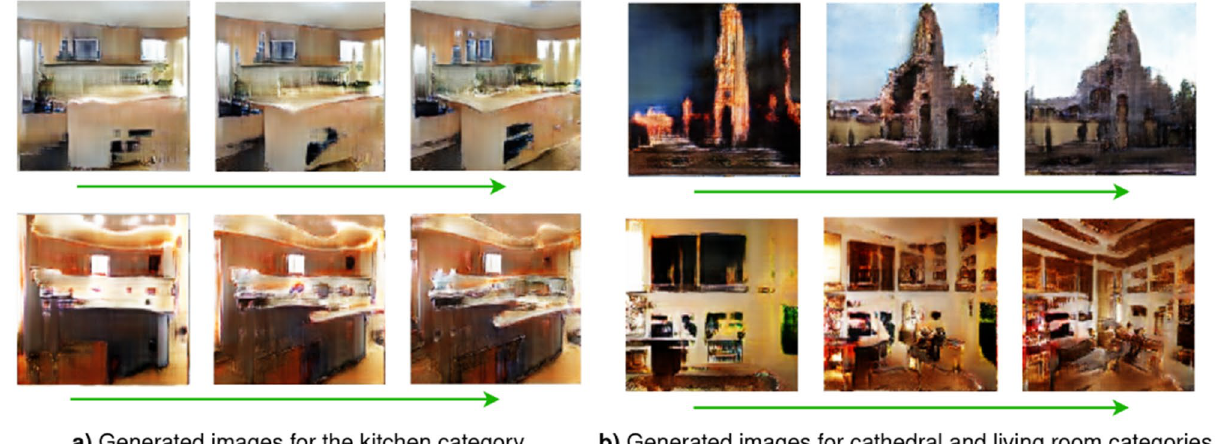
Figure 2. Generated images when fixing Z , where the sequence of generated images is displayed from left to right, while the memorability M is varied from low to high. Shown categories include kitchens, cathedrals, and living rooms.